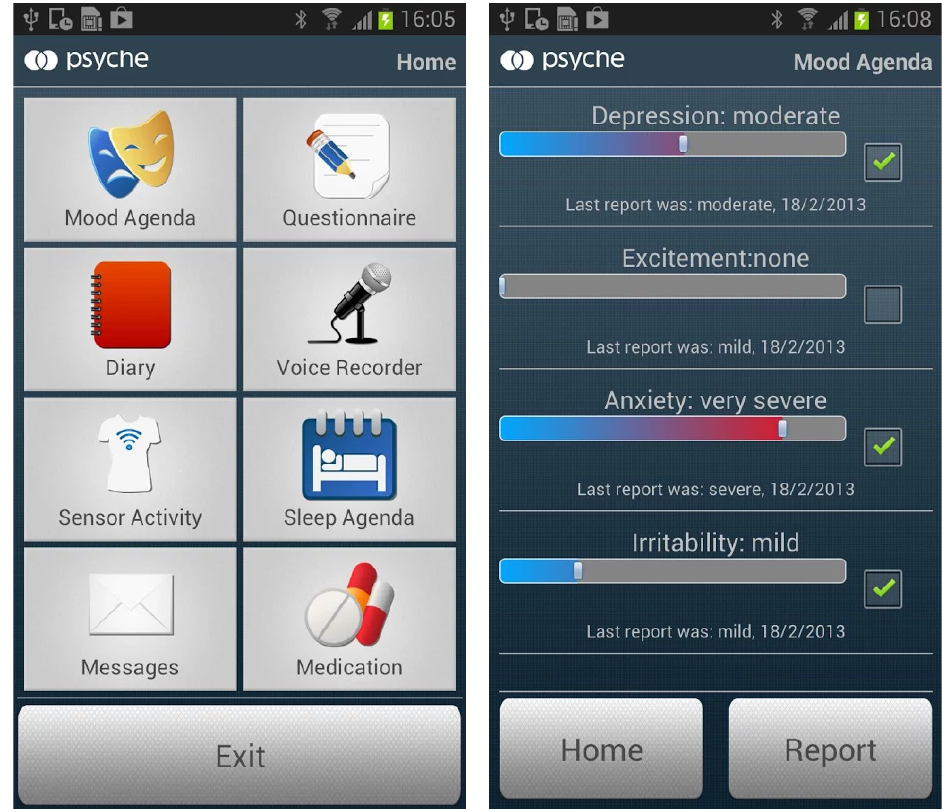
Figure 1. Screenshots of the developed application: main menu (left), and an example of the mood agenda